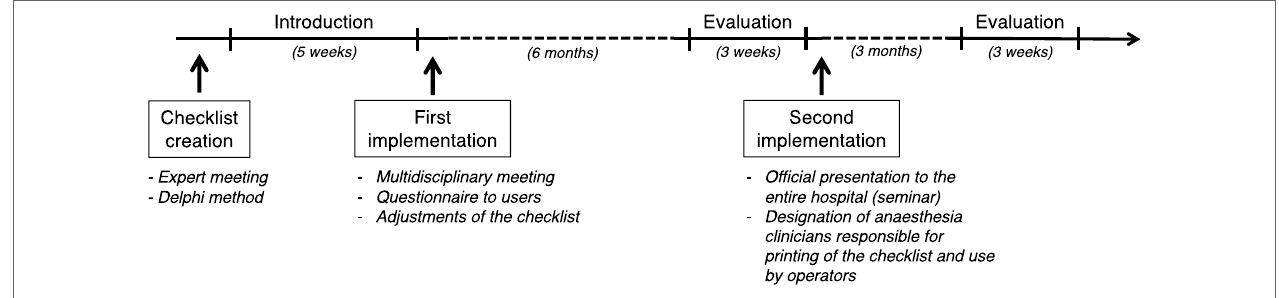
FigUre 1 | Time line of development, implementation, and evaluation of a perianesthetic safety checklist in the Small Animal Teaching hospital of the University of Bern. The checklist was created in an expert meeting using the Delphi method. The checklist was introduced in the clinics over a 5-week period. After introduction, a survey among the users was made and a multidisciplinary meeting was held, allowing the checklist to be adjusted to practice. Six months later, an evaluation of the use of the checklist was performed over a 3-week period. The tool was implemented a second time following oral introduction of the tool to the team and the designation of a responsible person. A second evaluation was performed 3 months